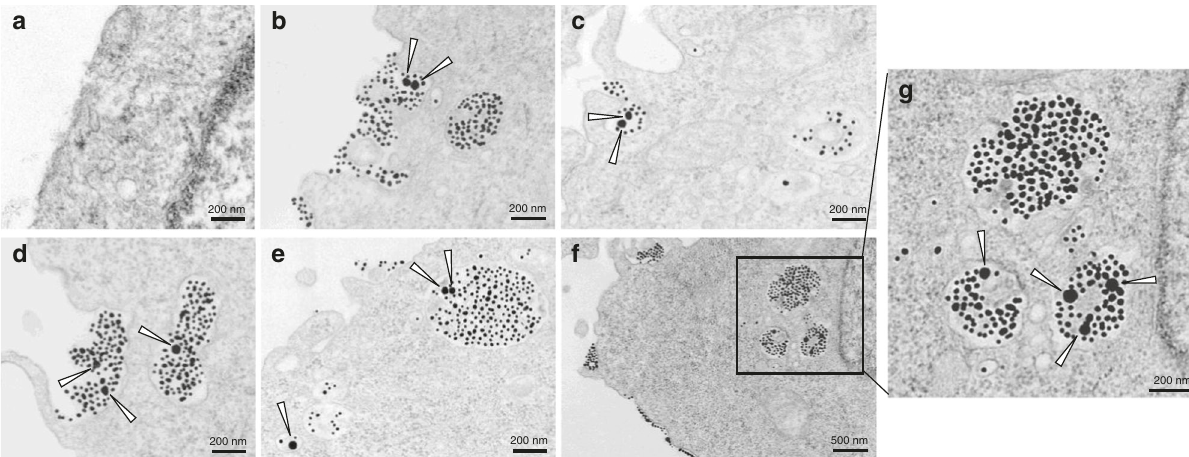
Fig. 3 TEM analysis of endocytic structures for bystander uptake. CHO cells were incubated with Au50 alone ( a ) or Au50 + T-Au ( b – g ) in DMEM medium for 1 h before being fi xed and processed for TEM imaging. The triangle arrows highlight the Au50 particles in the corresponding images. The Au50 particles were found together with T-Au in macropinosome-like endocytic vacuoles (>200-nm in diameter) ( b – d ), early endosome ( e , bottom l e ft), and late endosomes and lysosomes ( e , g ). Scale bars, 200 nm (except in f , in which is 500 nm). Three independent experiments ( n = 3) were performed and representative TEM images are shown here. Source data are provided as a Source Data fi